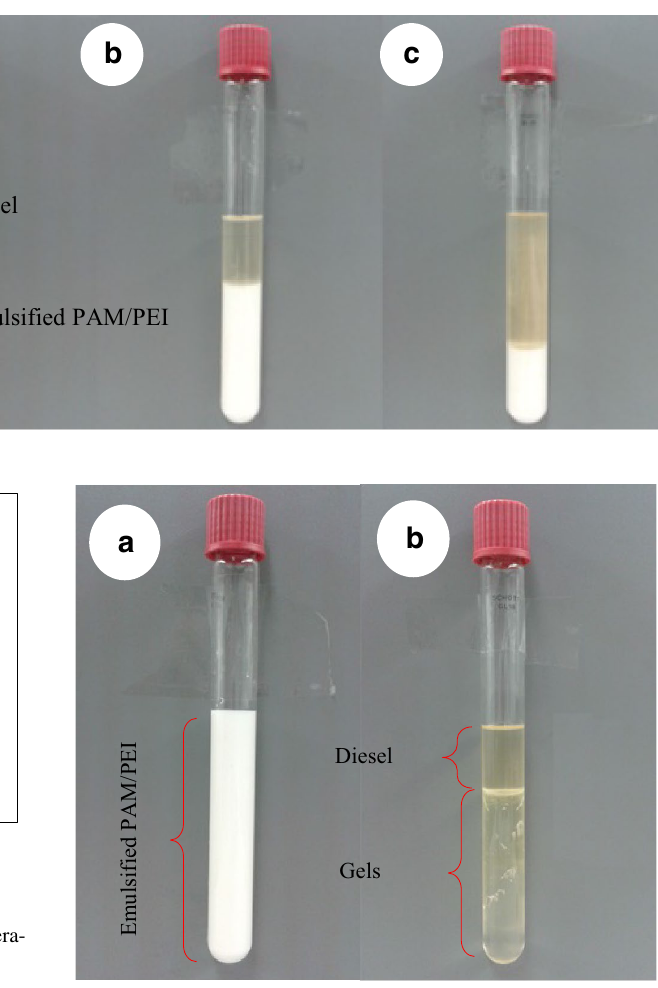
Fig. 12 Emulsified gel formulations: a no separation and b complete